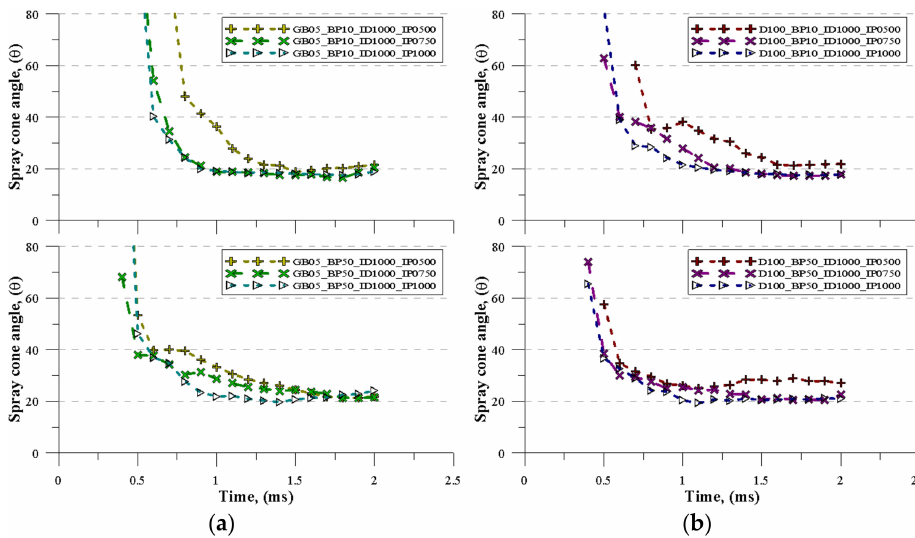
Figure 7. Spray cone angles of ( a ) GB05, and ( b ) D100 with an injection duration 1000 µ s at back pressures of 10 and 50 bar and injection pressures of 500, 750 and 1000